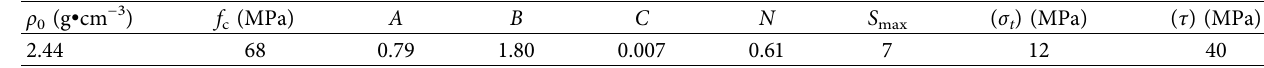
Table 1: Constitutive parameters for the